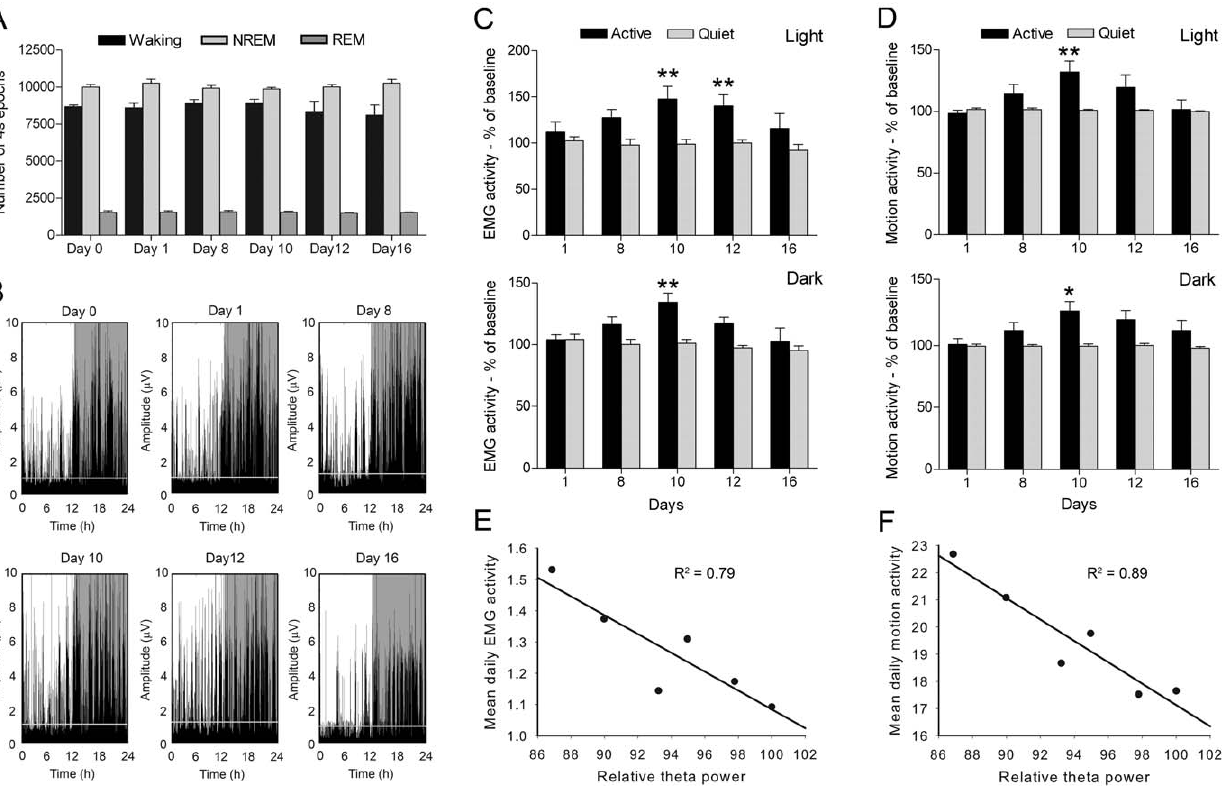
Figure 3. Effects of ceftriaxone treatment on motor activity. A. Time-course of the amount of time expressed in 4s epochs spent in waking, NREM and REM sleep. Values are expressed as mean 6 sem. B. Example of EMG activity during the entire length of the experiments. Note the intense activity after the end of CEF treatment. The grey line represents the threshold above and below which the motor activity is identified as active waking or quiet waking, respectively. C–D. Quantitative analysis of EMG activity (C) and Motion activity (D) during active and quiet waking for light and dark periods. Values are relative to the baseline (day 0) and expressed as mean 6 sem. * (p , 0.05), ** (p , 0.01). E–F. Negative correlation between the time-course of relative theta power and the EMG (E) or Motion activity (F).